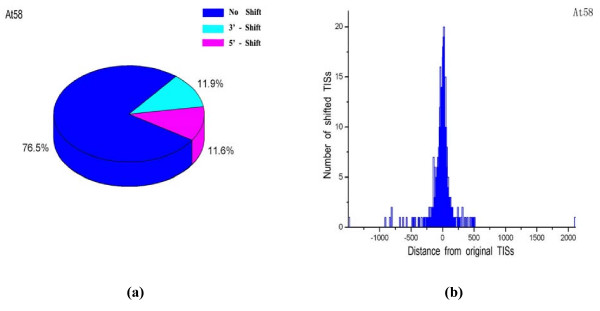
Statistics of relocated TISs for At58. (a) The statistical caky chart for At58. Blue regions denote the percentage of the same TISs as the RefSeq annotation. Pink and light blue regions denote the percentage of 5'-shift and 3'-shift from the RefSeq annotation, respectively. (b) The histogram of relocated TISs for At58. Negative and positive values in x-axis indicate the length of 5'-shift and 3'-shift from the RefSeq annotation, respectively, and y-axis indicates the number of shifted TISs.